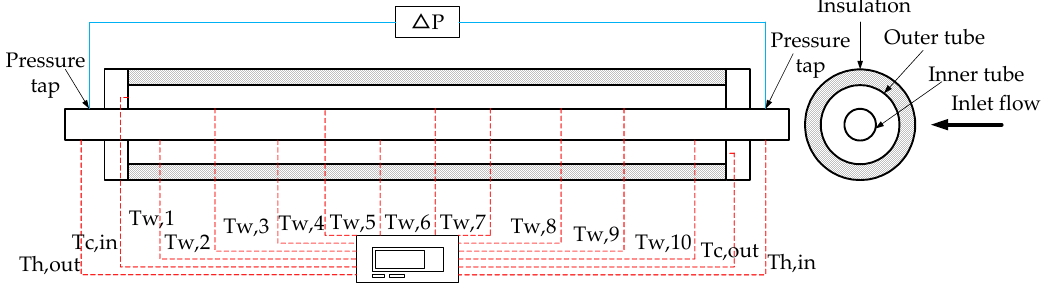
Figure 2. Schematic diagram of the enhanced heat-transfer test section with measurement points for registering temperature and pressure.